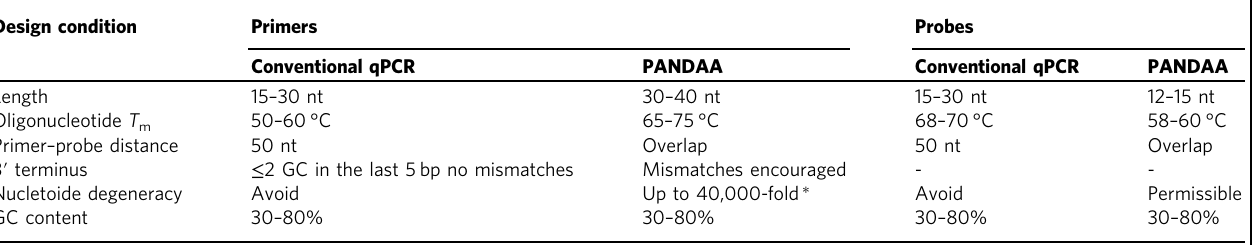
Table 1 PANDAA improves sensitivity to detect single nucleotide changes in HIV-1 compared to conventional qPCR. Design